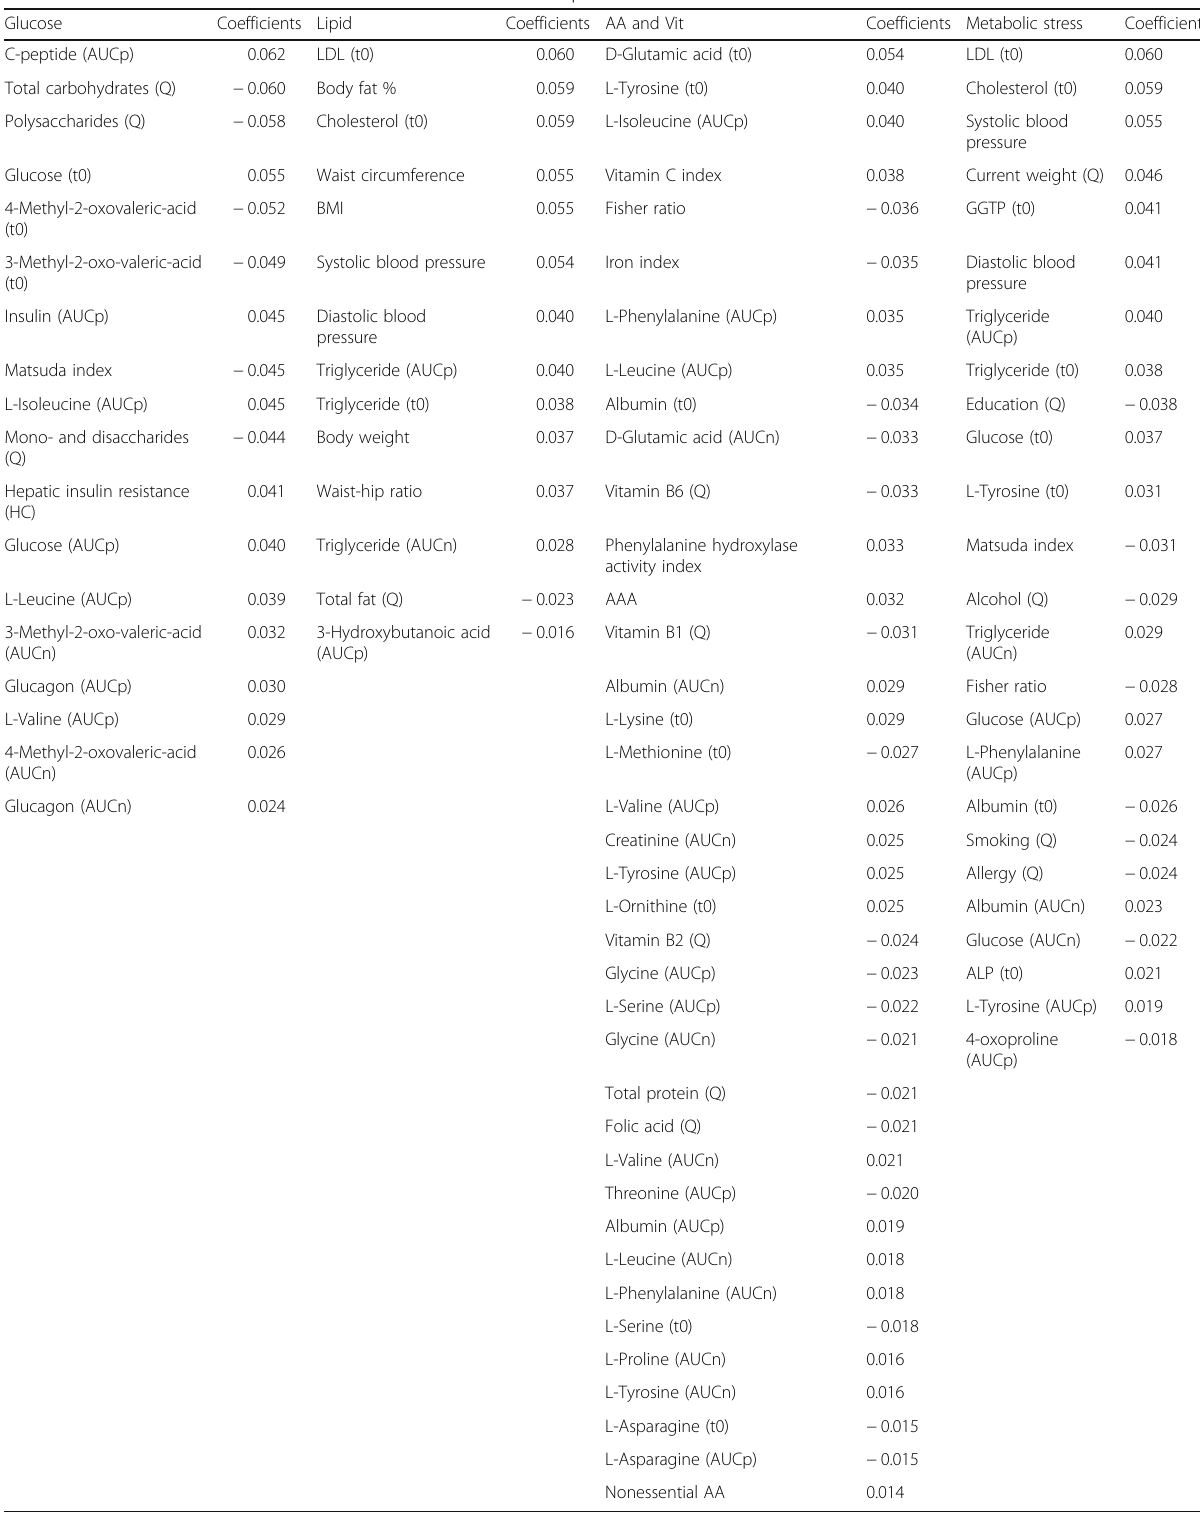
Table 2 The selected features for the four axes of the health space